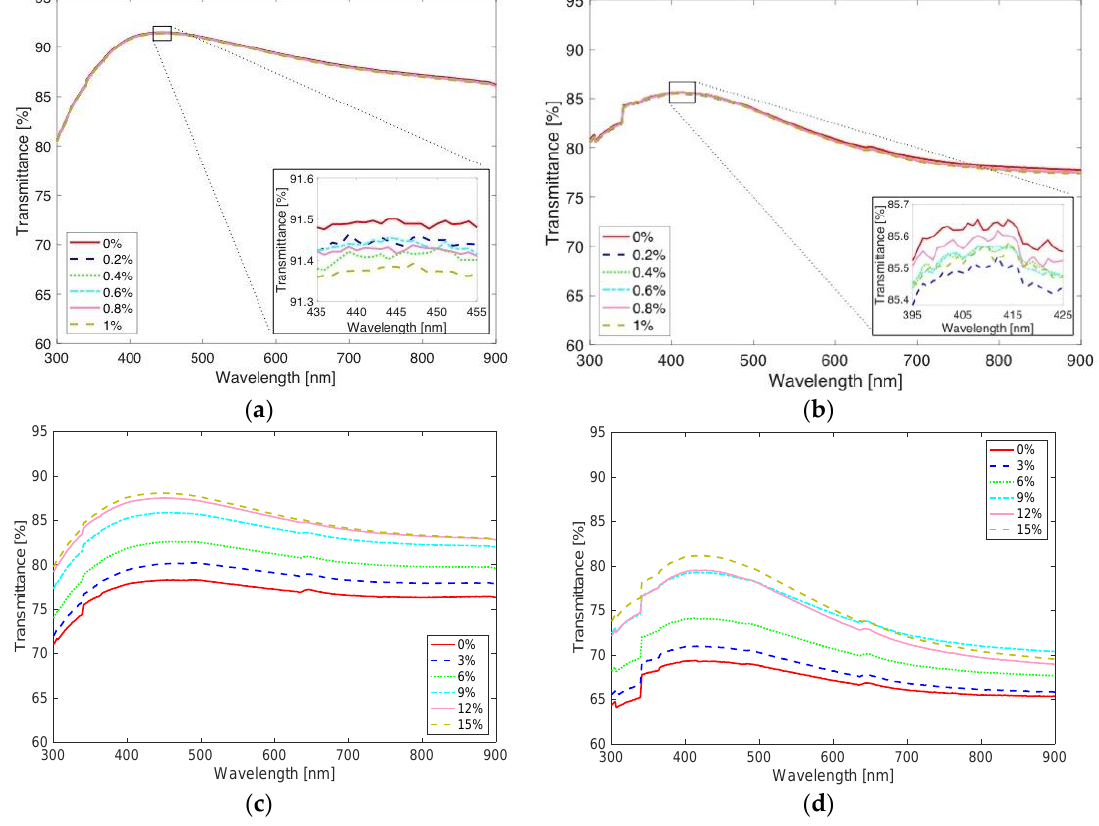
Figure 5. Light transmittance spectrums are shown at various tensile strains during loading. The spectrums are acquired from specimens ( a ) 1P1L, ( b ) 1P9L, ( c ) 15P1L, and ( d ) 15P5L.